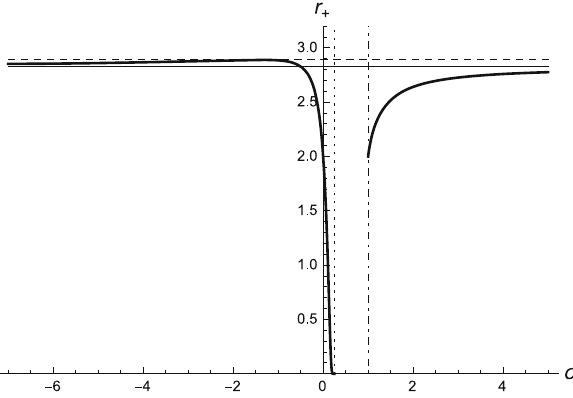
Fig. 1 The behavior of the DST horizon as a function of σ with r S =